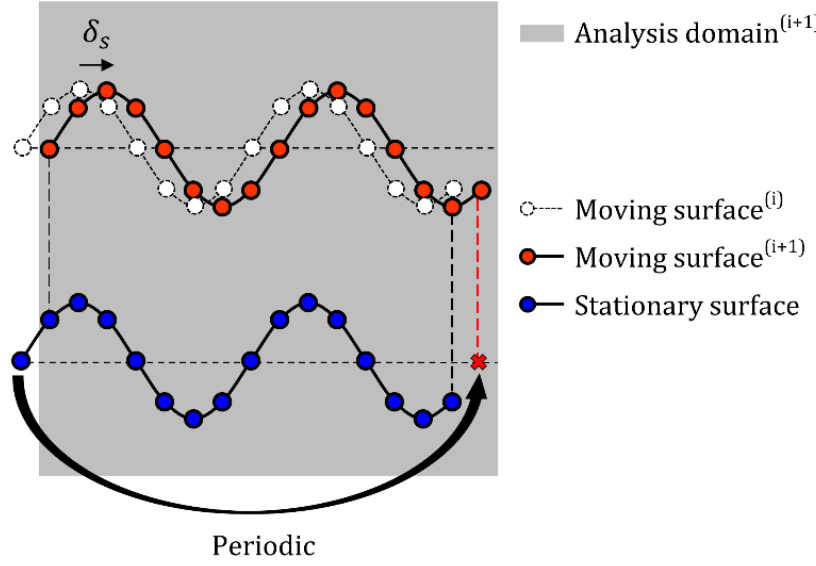
Figure 2. Schematic of data movement to account for changing contact points of asperities.